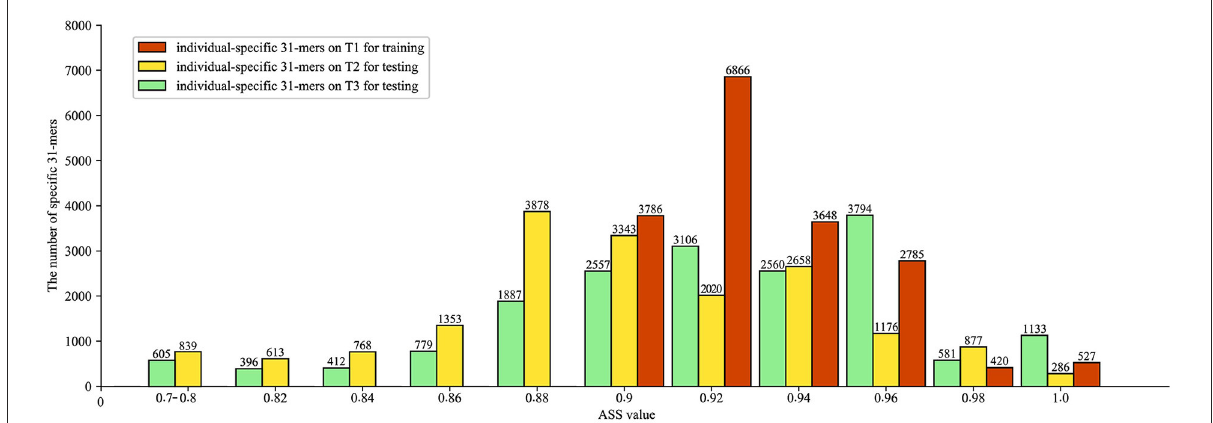
FIGURE5 Evaluation of temporal stability of identified individual-specific k -mers, showing specific k -mers identified by ASS value of HV08 individual-specific 31-mers at three sampling times. Red bars represent individual-specific 31-mers on training, while yellow and green bars represent individual-specific 31-mers on two test datasets, respectively. The number above the bar chart represents the number of individual-specific 31-mers included in that ASS value.